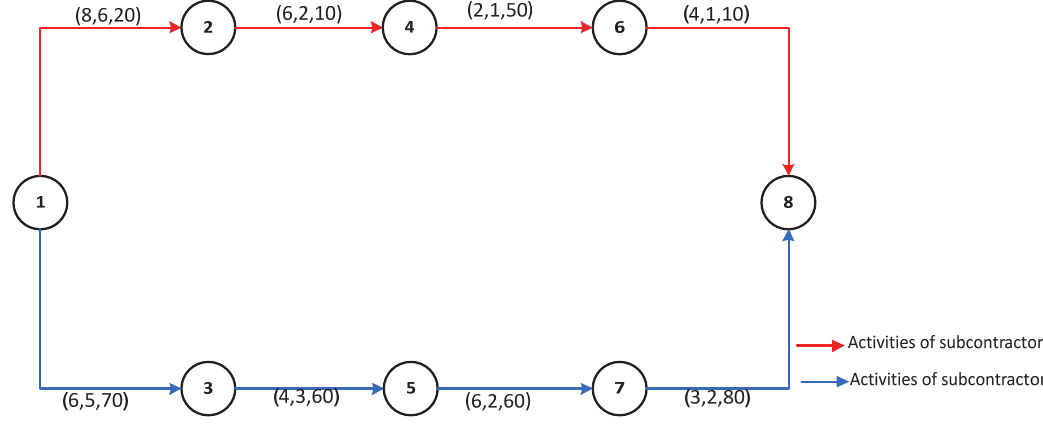
Fig. 3. AoA network for two subcontractors